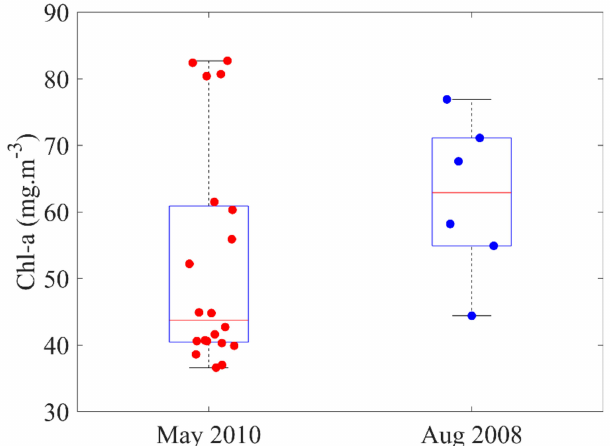
Figure 2. Box-plots of the summary statistics for chlorophyll-a (Chl-a) in 2008 and